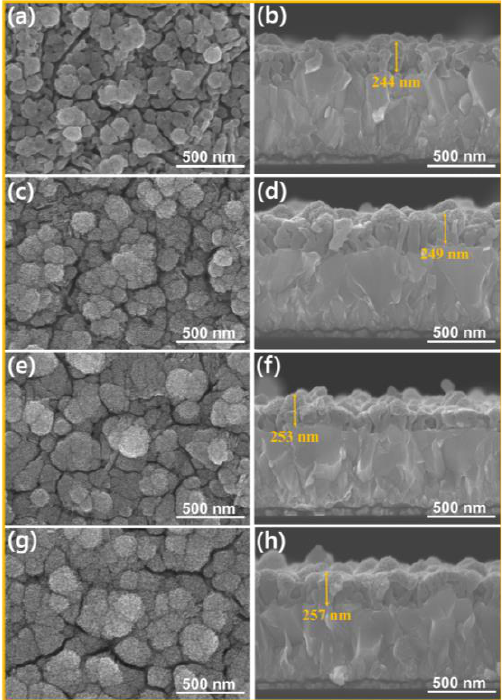
Figure 1. HR−FESEM image (left; top and right; cross -sectional view) of the ( a , b ) Zr/HT, ( c , d ) 2:Al- Figure 1. HR − FESEM image (left; top and right; cross-sectional view) of the ( a , b ) Zr/HT, Zr/HT, ( e , f ) 6:Al-Zr/HT, and ( g , h ) 10:Al-Zr/HT photoanodes. ( c , d ) 2:Al-Zr/HT, ( e , f ) 6:Al-Zr/HT, and ( g , h ) 10:Al-Zr/HT